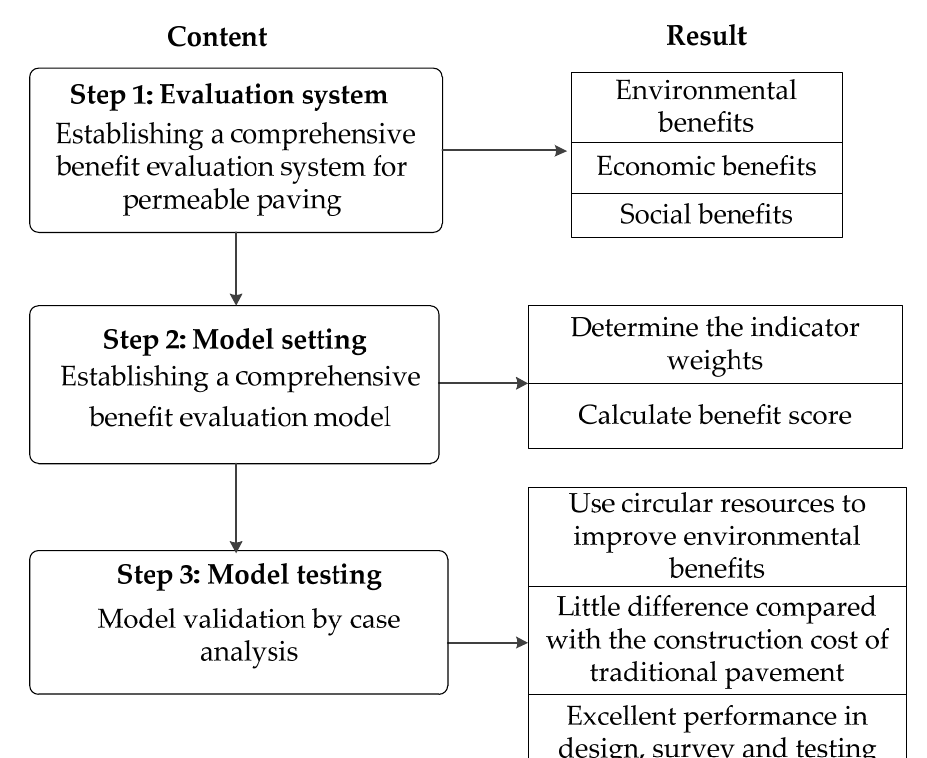
Figure 5. Summary of the key findings of this study.